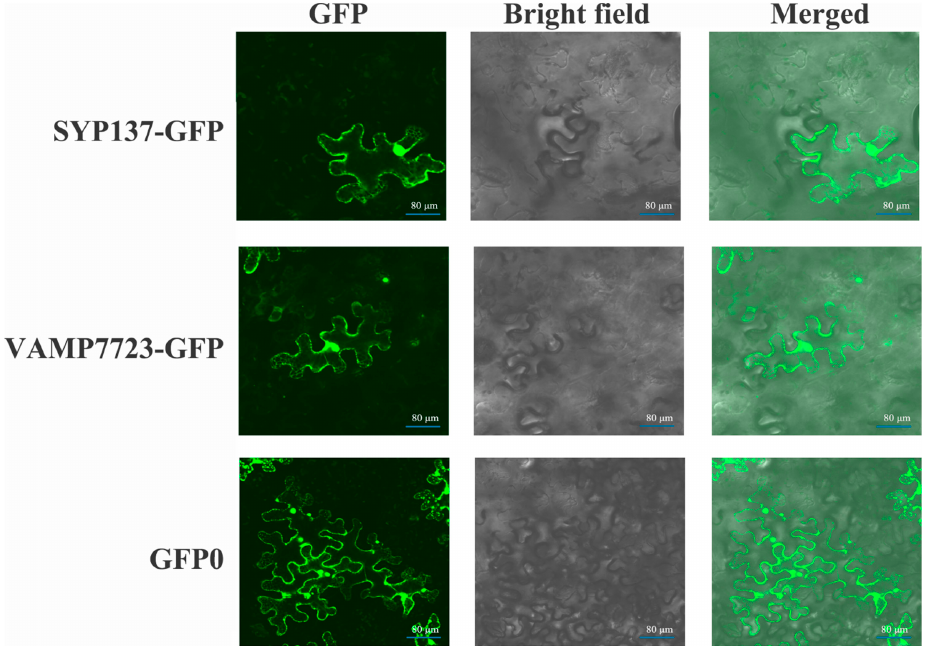
Figure 3. Transient expression and localization of TaSYP137 and TaVAMP723 fusion proteins in Nicotiana benthamiana non-plasmolyzed epidermal cells. The fusion vector pYJ:TaSYP137:GFP, pYJ:TaVAMP723:GFP and the pYJ::GFP control (Ck, marker with GFP0) vectors were transformed into tobacco epidermal cells by Agrobacterium . The subcellular distribution of GFP in the epidermal cells was revealed by fluorescence scanning microscopy.